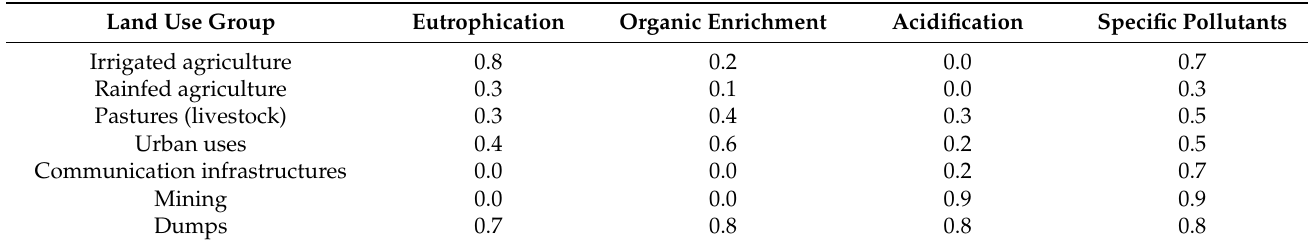
Table 2. Weighting factors applied for the quantification of the pressure type level for each land use group. Land Use Group Eutrophication Organic Enrichment